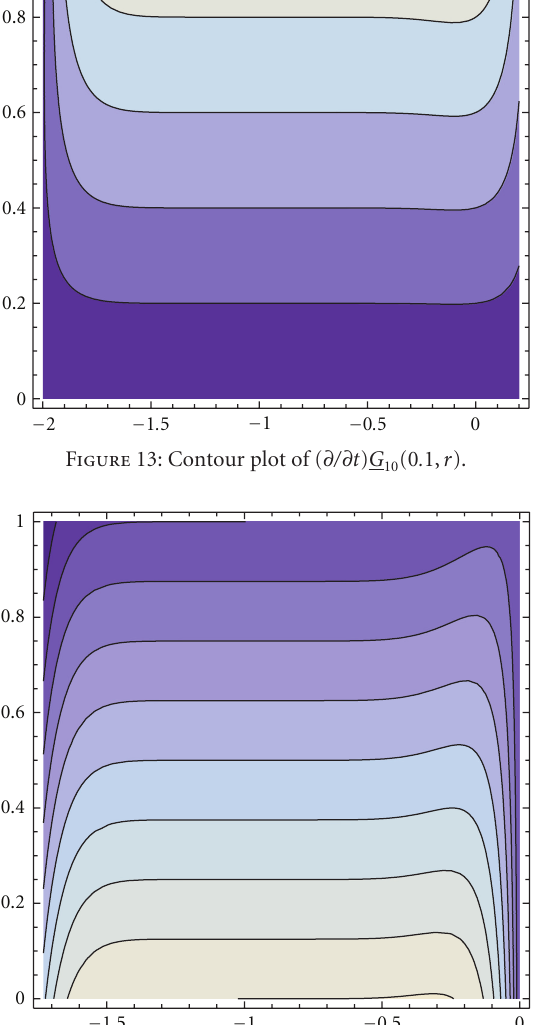
Figure 14: Contour plot of ( ∂/∂t ) G 10 (0 . 1, r ).